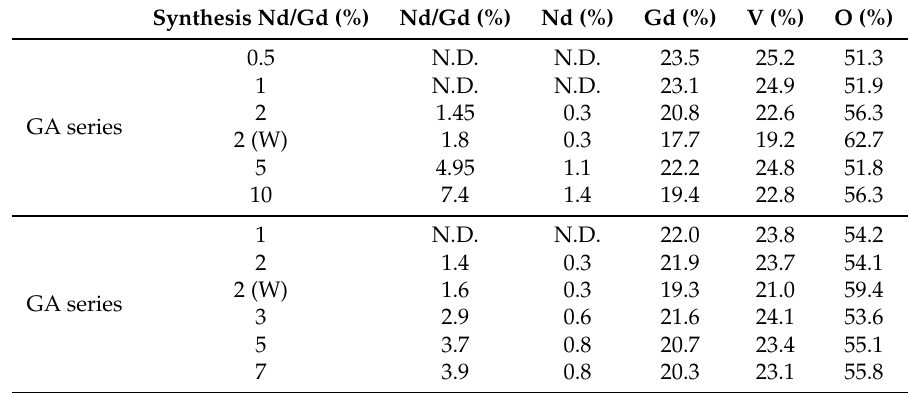
Table 2. EDX concentrations (at%) in the samples from the GA and GV series. N.D. means that the concentration fell below the detection limit.